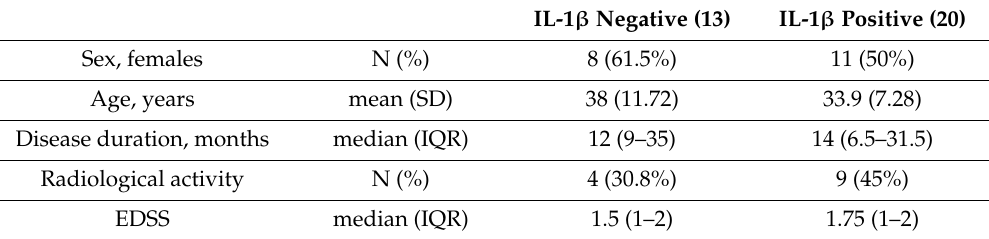
Table 2. Clinical Characteristics of MS Patients According to IL-1 β